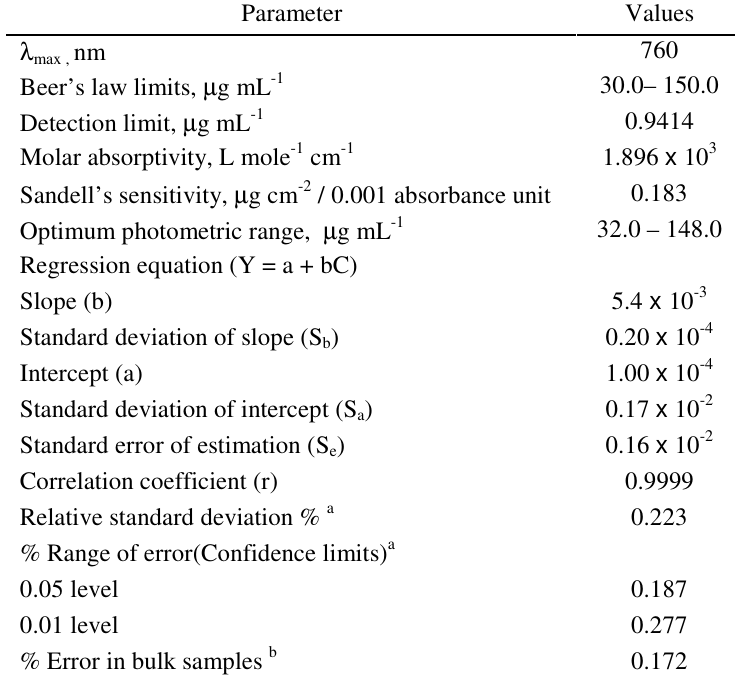
Table 2 . Optical and Regression Characteristics, Precision and Accuracy of the Proposed Method for TSM